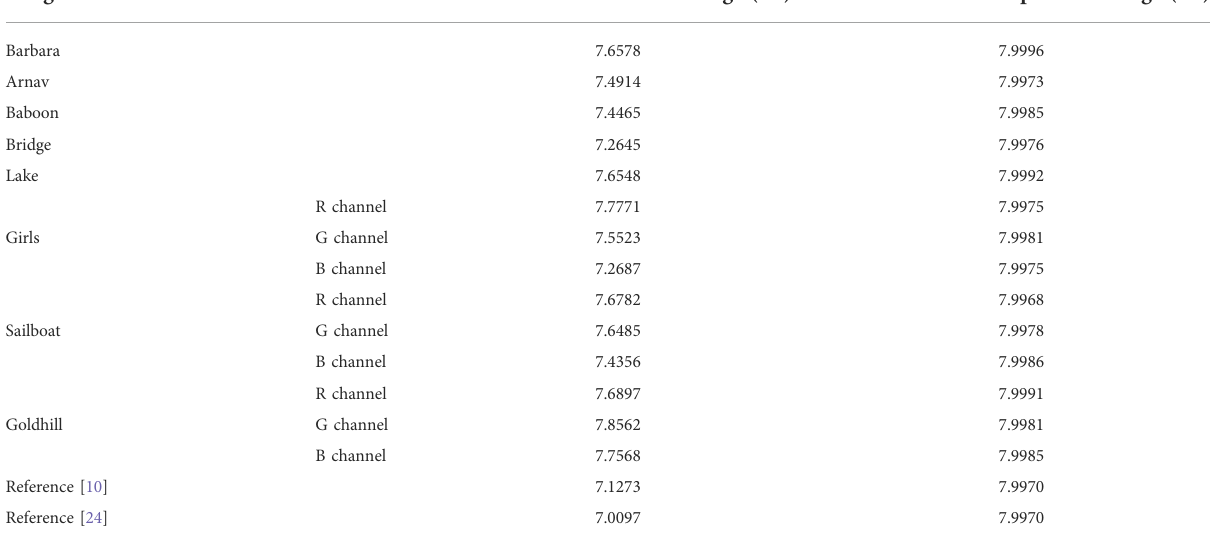
TABLE 4 Information entropy.